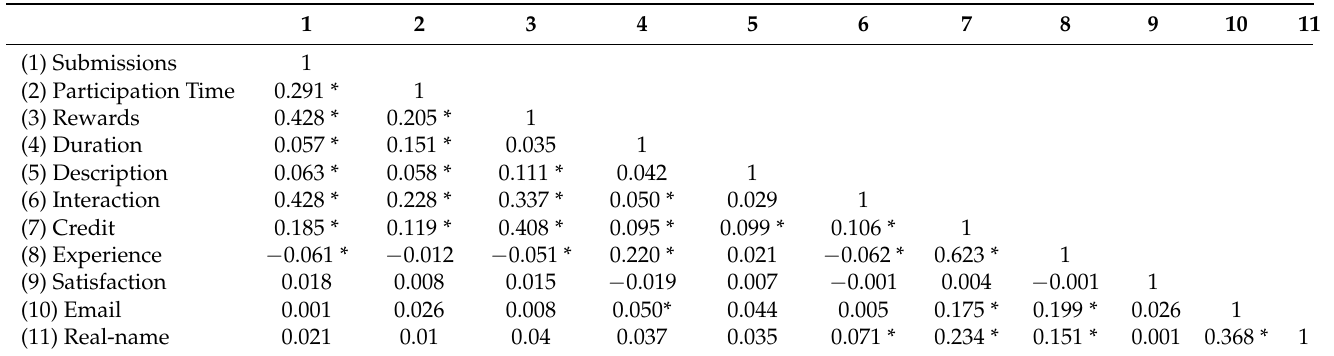
Table 4. Correlation coefficients of the main